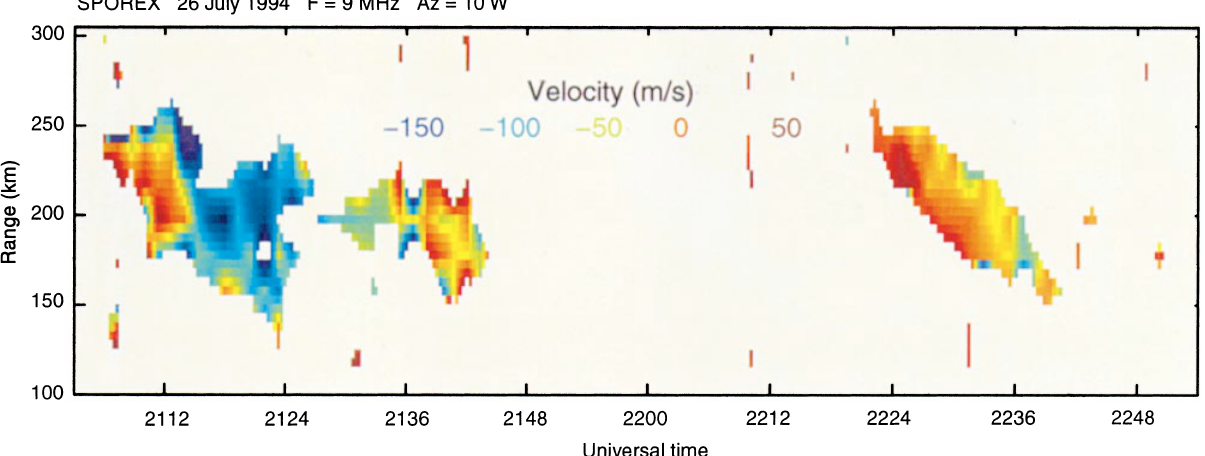
Fig. 5. Plot of the Doppler velocity during the E-region scattering event. Note the small positive velocities ( (cid:24) 25 m/s) in the scattering regions with negative range rate and the large negative velocities ( ) 100 to ) 150 m/s) observed in the scattering regions with a positive range